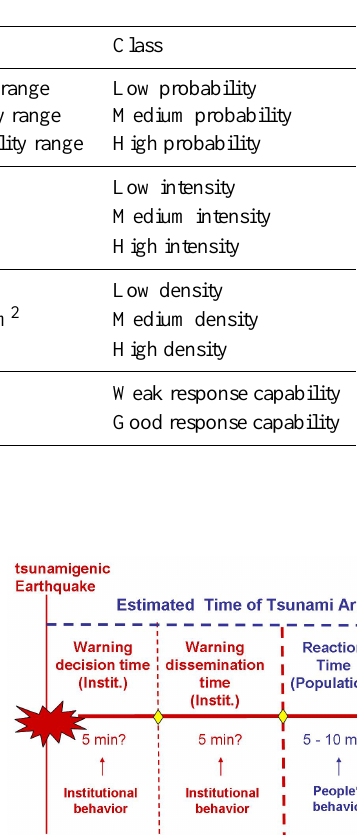
Table 2. Classification of risk assessment input data.